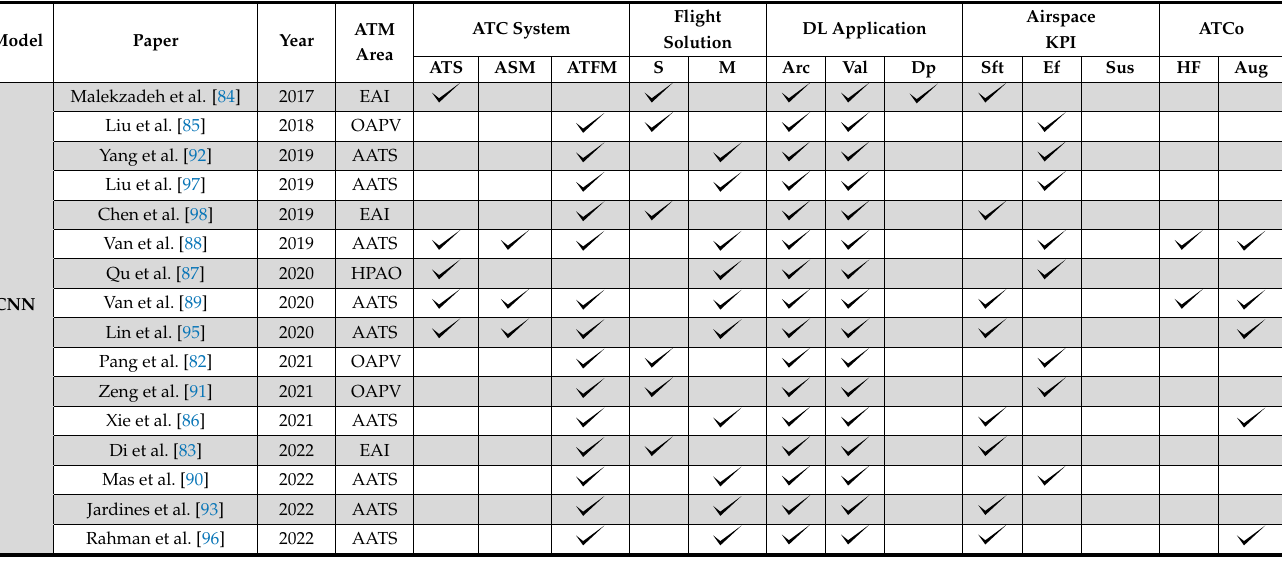
Table 1. Comparison of works that use Deep Learning (DL) in ATM